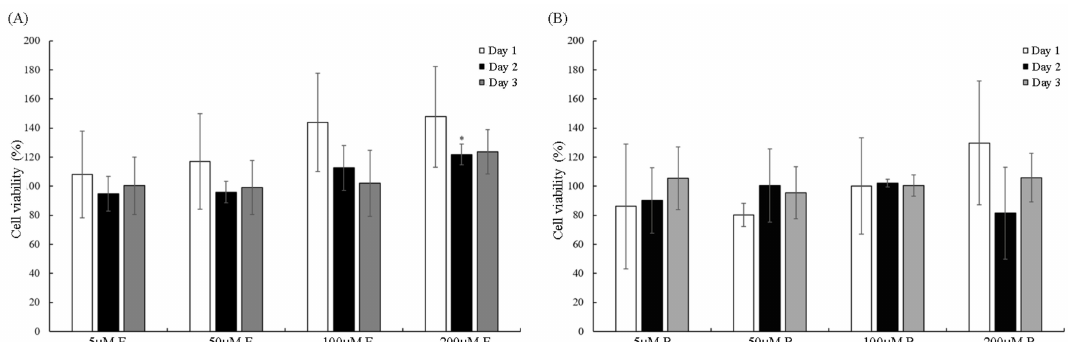
Figure 2. The cell viability of vitamin E and resveratrol at various concentrations. ( A ) L929 cells were cultured with 5, 50, 100, or 200 µ M of vitamin E for 1 (white bars), 2 (black bars), or 3 (gray bars) days. The cell viability increased when the concentration of vitamin E was higher. * p < 0.05 compared with the cell viability at 5 µ M. ( B ) When the L929 cells were cultured with 5, 50, 100, and 200 µ M of resveratrol for 1 day, the cell viability increased depending on the concentration of resveratrol.